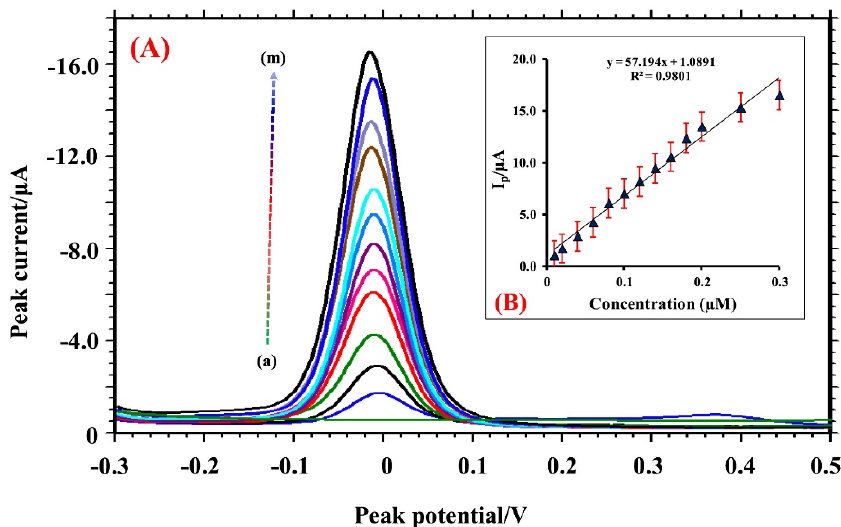
Figure 7. ( A ) SWV response at various concentration level of DCN (a) blank, (b) 10 μ M, (c) 20 μ M, (d) 40 μ M, (e) 60 μ M, (f) 80 μ M, (g) 100 μ M, (h) 140 μ M, (i) 180 μ M, (j) 220 μ M, (k) 260 μ M, (l) 300 μ M, (m) 350 μ M. Inset ( B ) calibration plot. Reproduced from reference [148] with permission from Elsevier, copyright 2022.